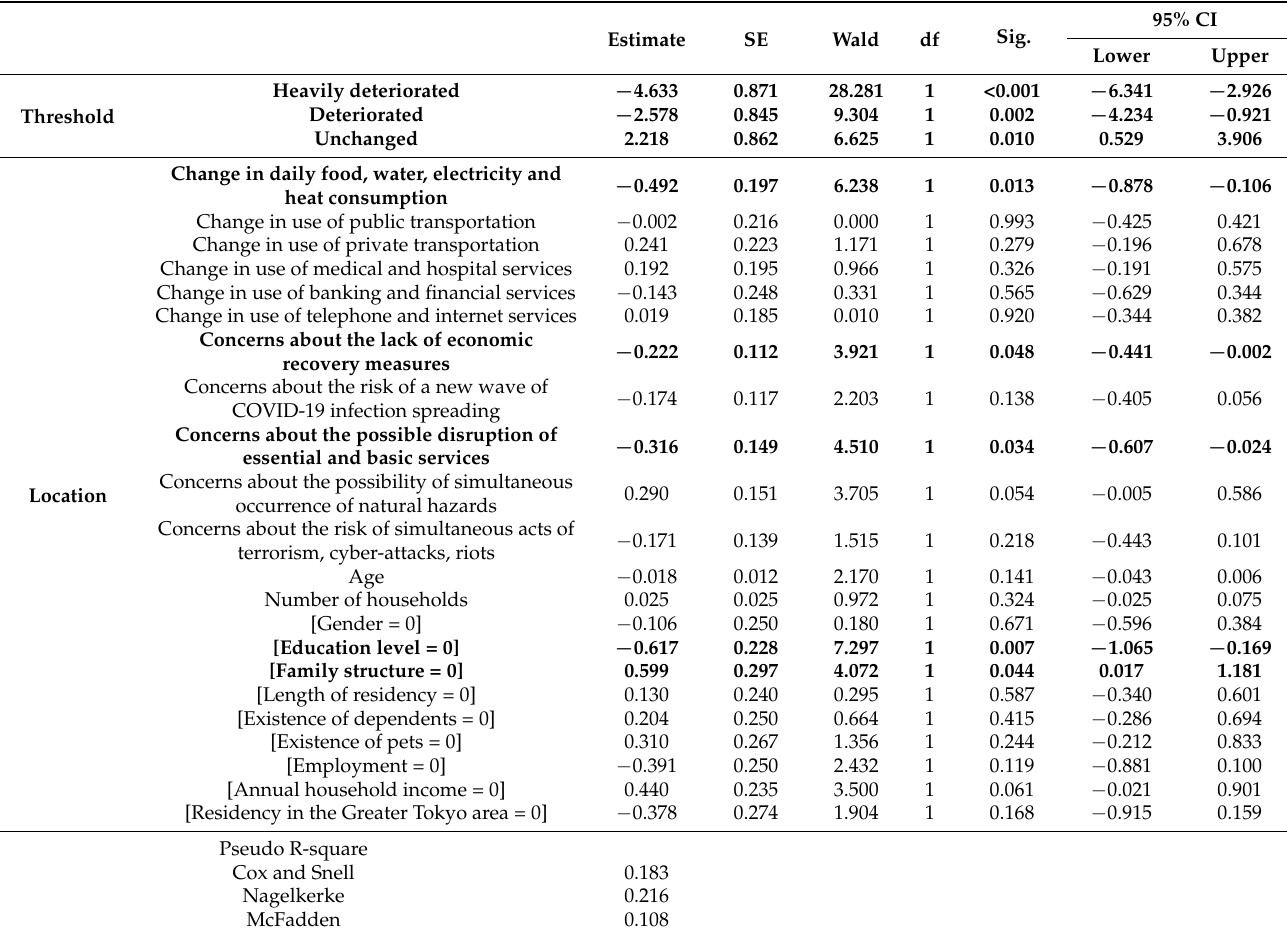
Bold font indicates statistical significance at the 5%